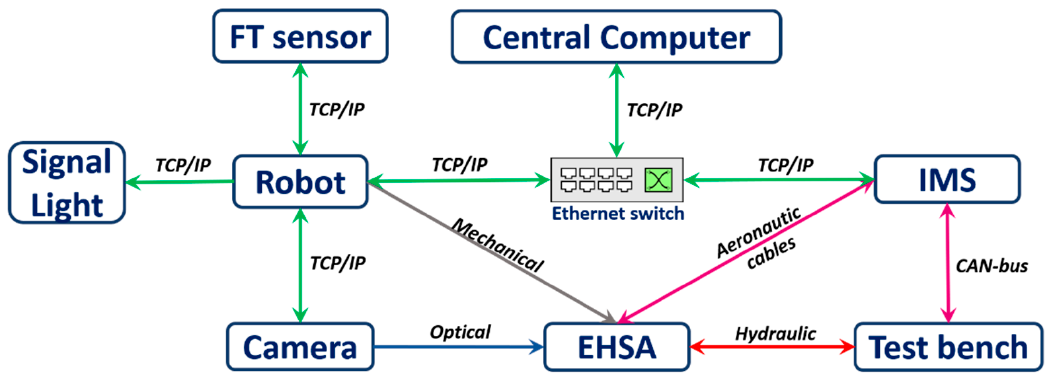
Figure 4. Overview of the communication network implemented to allow autonomous maintenance on electro-hydraulic servo-actuators.